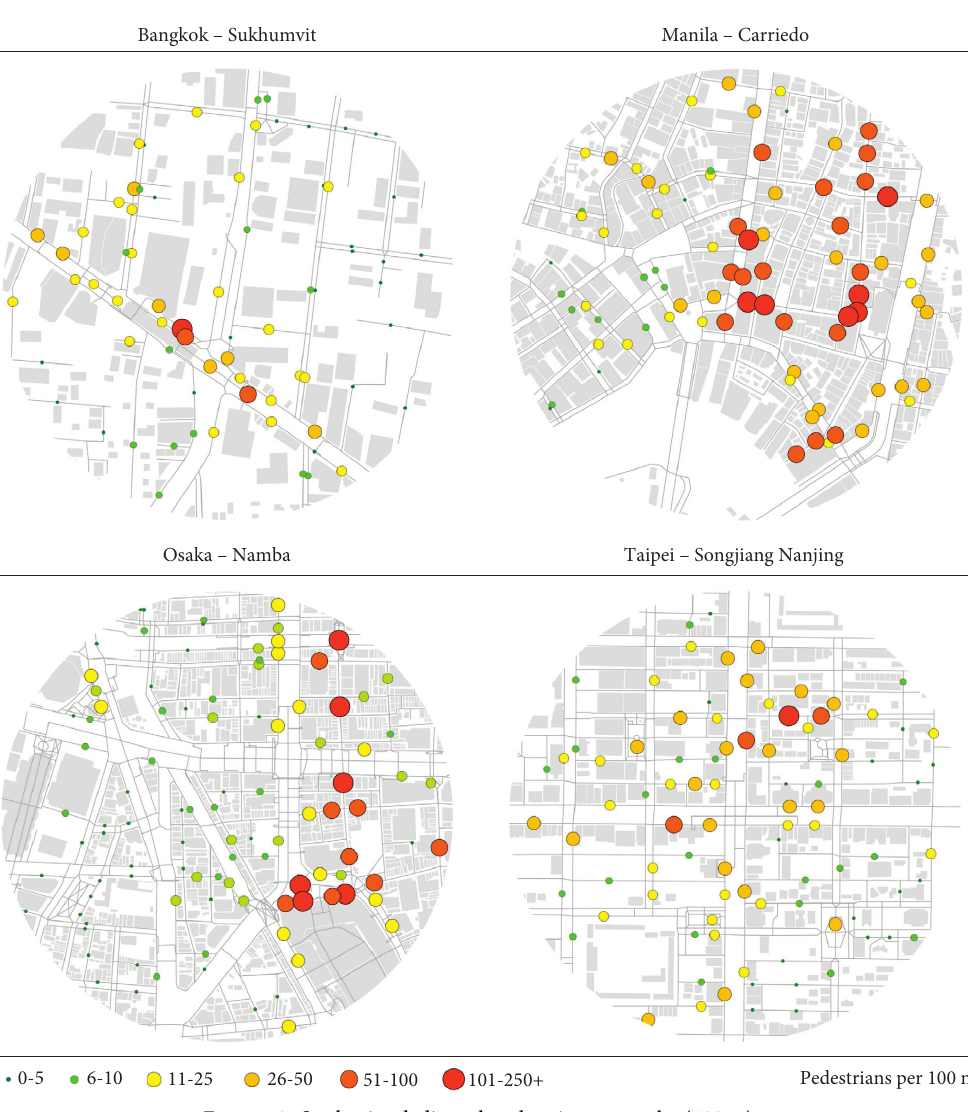
Figure 2: Study site dedicated pedestrian networks (400 m).